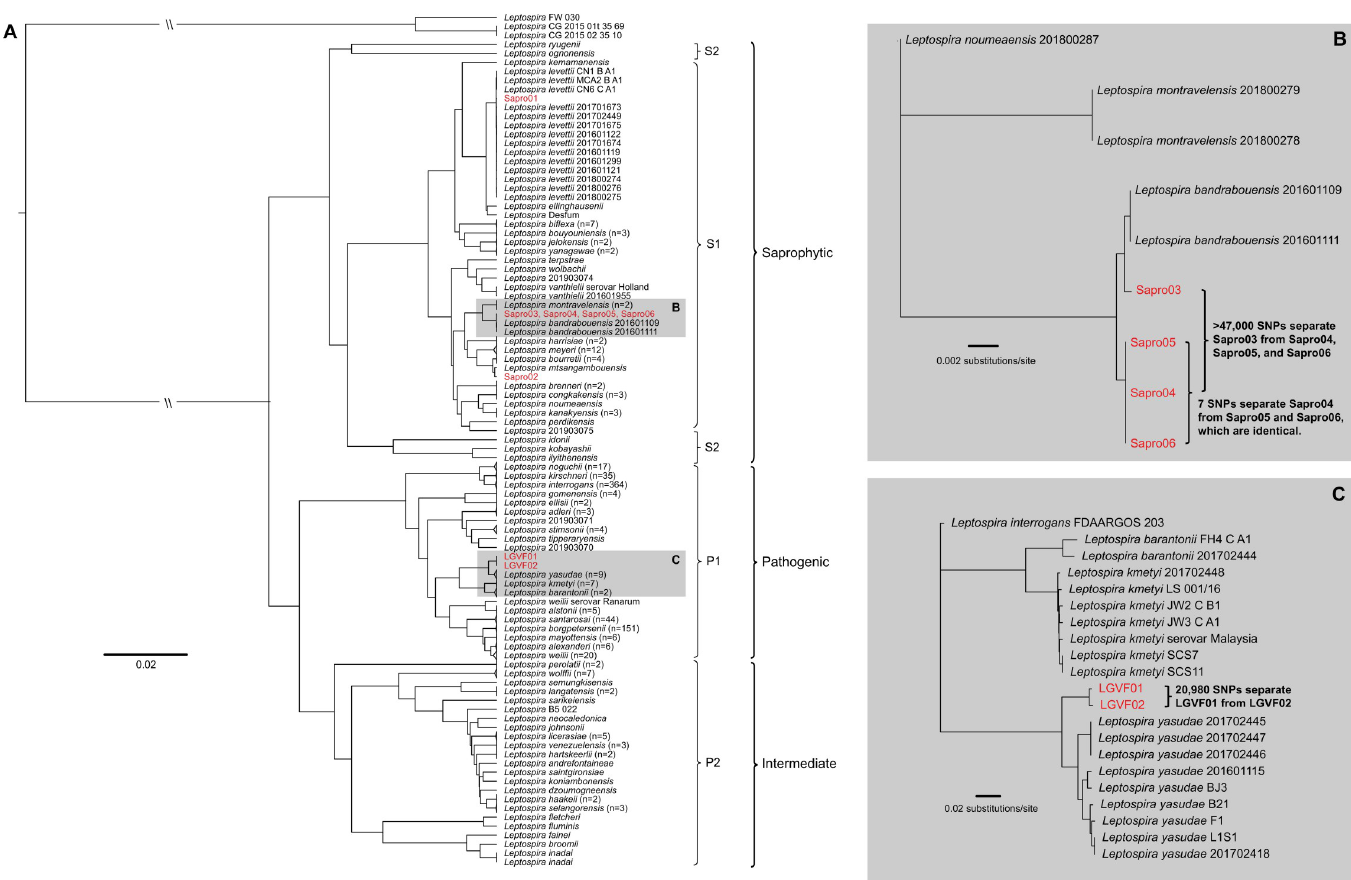
Fig 4. Whole genome dendrogram of 802 known pathogenic, intermediate, and saprophytic Leptospira spp. isolates, including six saprophytic and two pathogenic isolates obtained in this study from a single soil sample from site 16. A) Pairwise genomic distance dendrogram contextualizing the relationship among all known saprophytic (S1 and S2), intermediate (P2), and pathogenic (P1) Leptospira spp. reveals the pathogenic isolates LGVF01 and LGVF02 represent two genotypes of the same previously undescribed pathogenic species, whereas the saprophytes belong to three known Leptospira spp. B) Detailed view of the S1 clade that contains four saprophytic isolates obtained during this study. This maximum likelihood phylogeny reveals significant diversity among isolates that fall within the L . bandrabouensis clade. C) Detailed view of the P1 clade that contains two pathogenic isolates obtained during this study. This maximum likelihood phylogeny reveals two genotypes of a novel pathogenic Leptospira spp. isolated from soil in Puerto